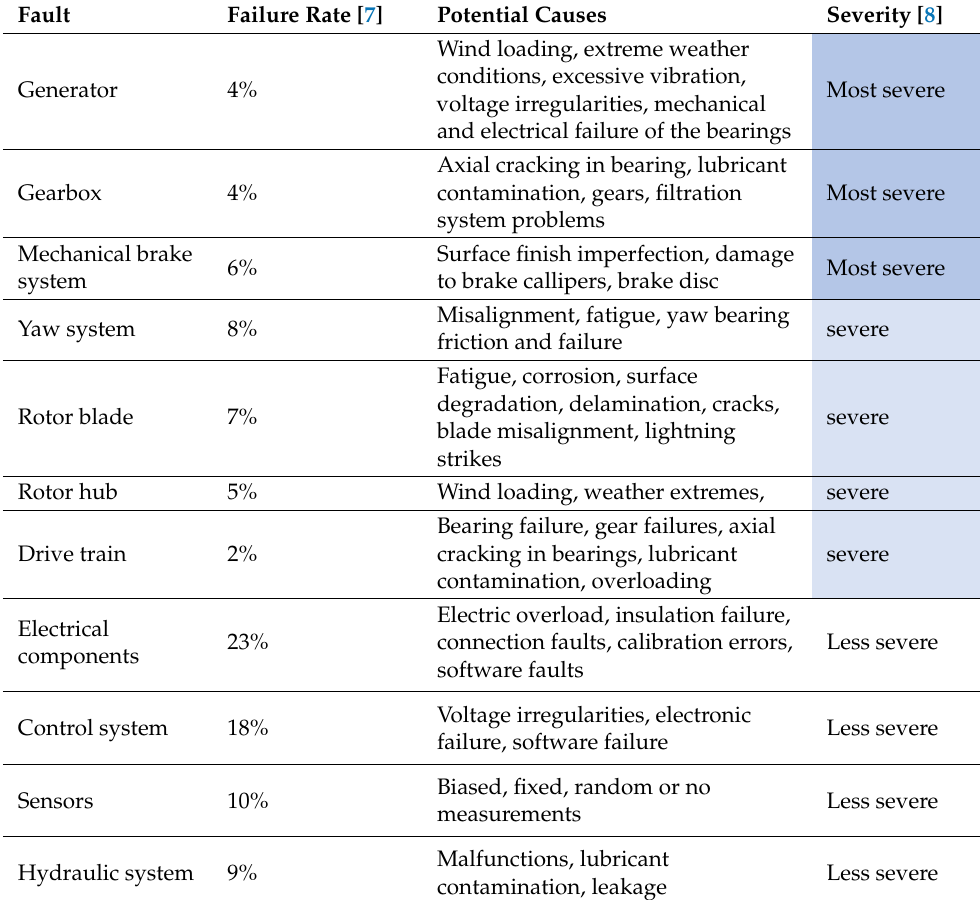
Table 1. List of typical faults, their occurrence and severity.